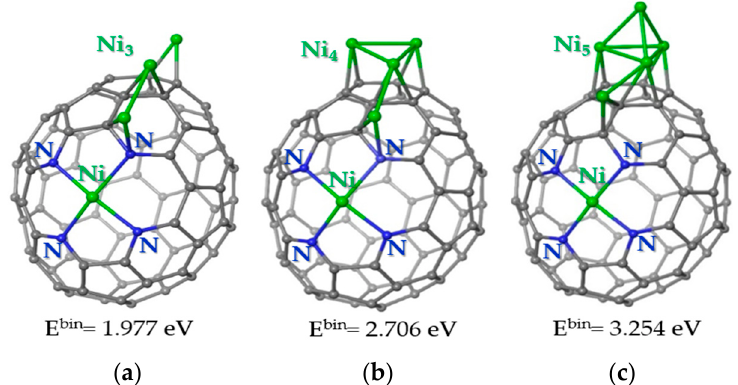
Figure 9. Energetically preferable locations of ( a ) three Ni atoms, ( b ) four Ni atoms, and ( c ) five Ni atoms on the carbon cage with the Ni-N 4 site. Carbon, nitrogen and nickel are shown by grey, blue and green balls, respectively. The values correspond to the binding energy for the newly arrived Ni atom. A positive value indicates an energy gain. The ground state is triplet for structure ( a ) and quintet for structures ( b ) and ( c ).